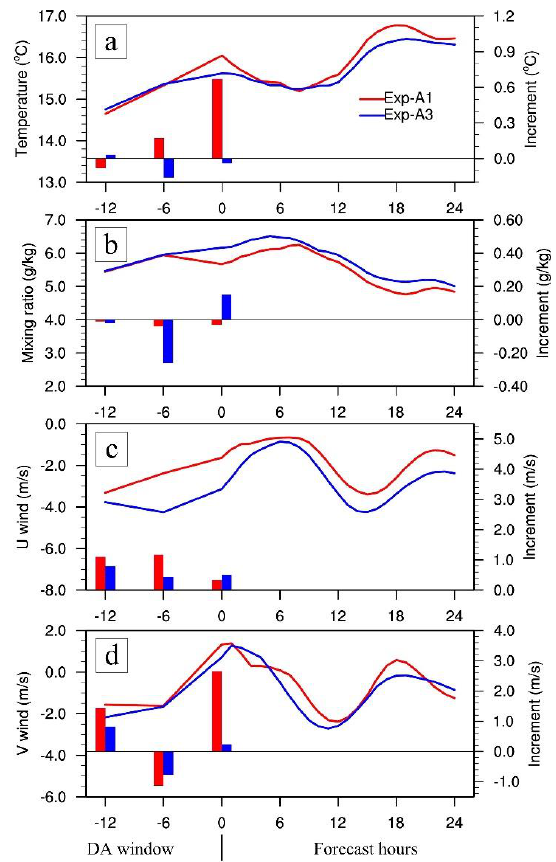
Figure 12. Time series of the average ( a ) temperature, ( b ) mixing ratio, ( c ) u, and ( d ) v wind components over the area marked by the dashed frame in Figure 8 for Exp-A1 (red) and Exp-A3 (blue). The bars show the analysis increments within data assimilation window.